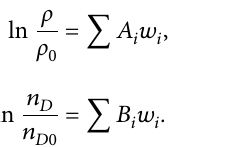
Figure 4: Dry-salt diagram of the quaternary system (NaCl+NH 323.15